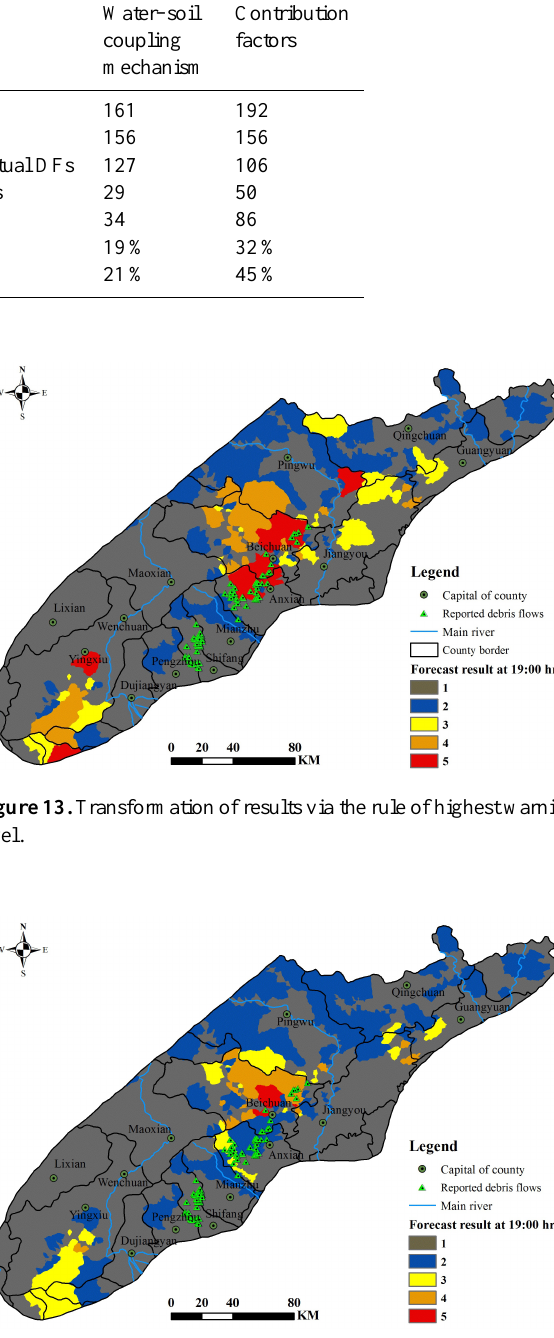
Figure 14. Transformation of results via the rule of most common warning